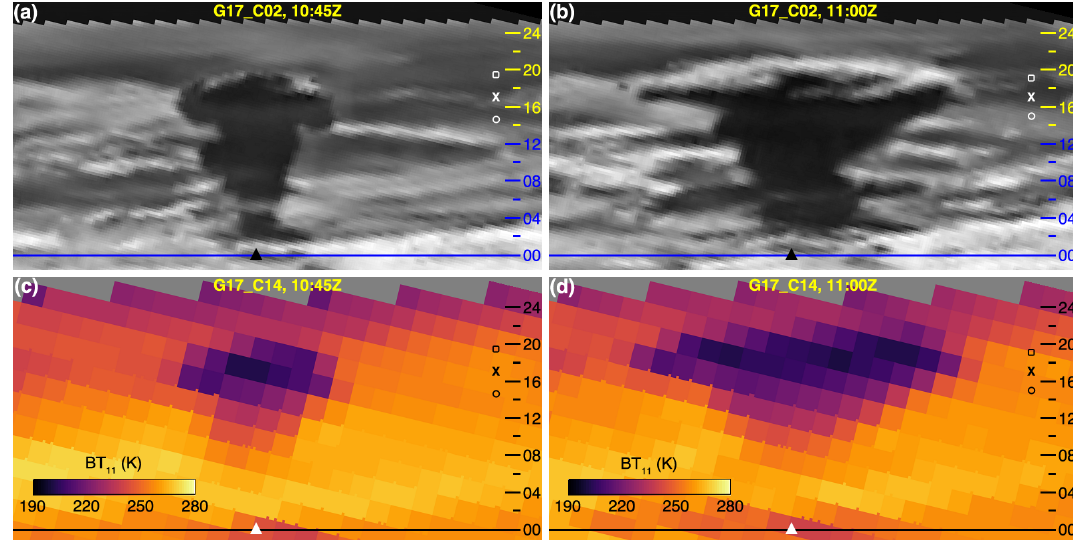
Figure 9. The eruption plume on 11 April 2021 at (a, c) 10:45UTC and (b, d) 11:00UTC in GOES-17 imagery: (a, b) channel 2 and (c, d) channel 14, with elevation markings as in Fig.